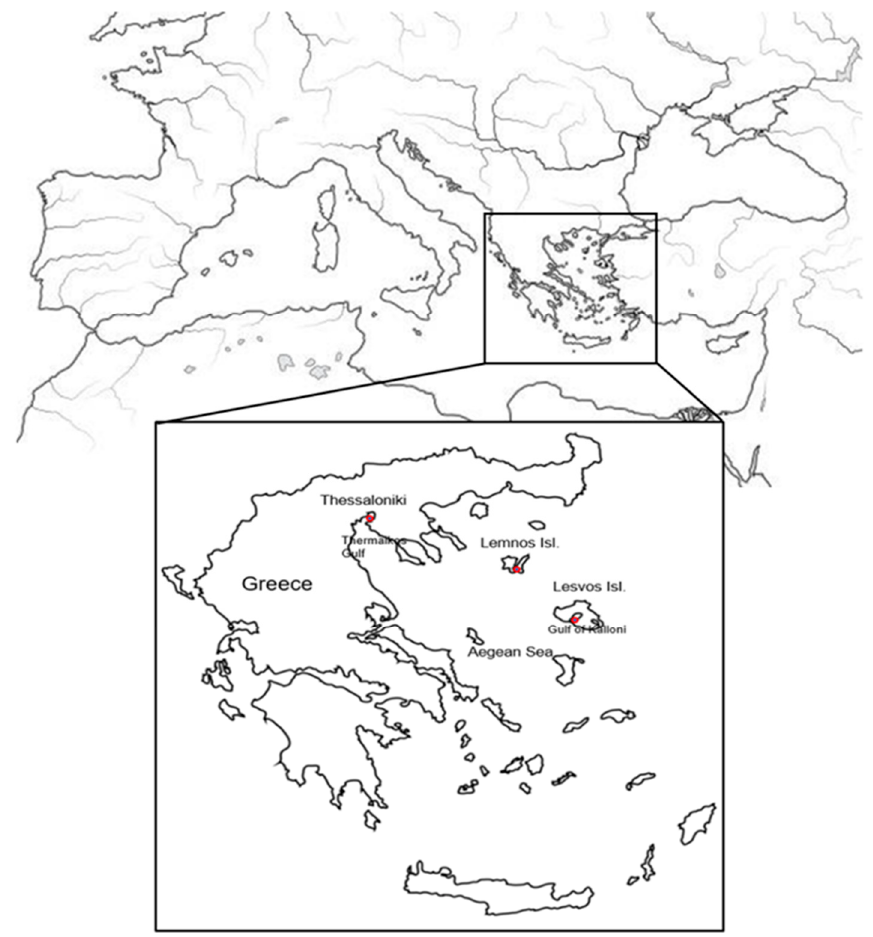
Figure 1. Origin of specimens used for the research.